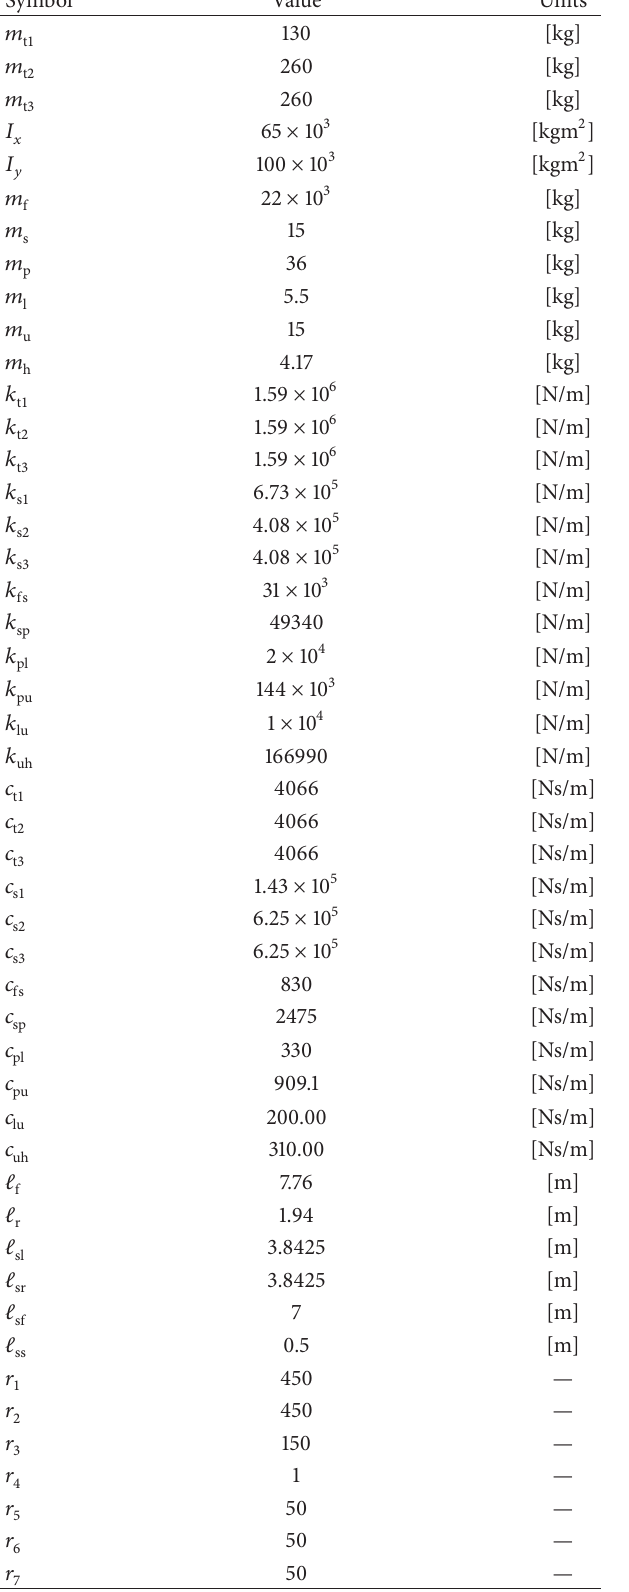
Table 1: The parameter values of the proposed full aircraft model and the numerical values of controlled variables coefficients.